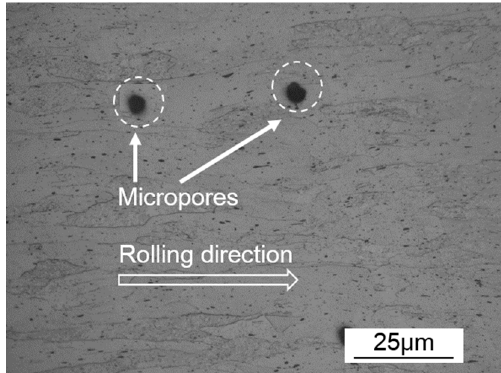
Figure 1. Cross-sectional microstructure of hot-rolled powder metallurgy NS-Mo alloy.